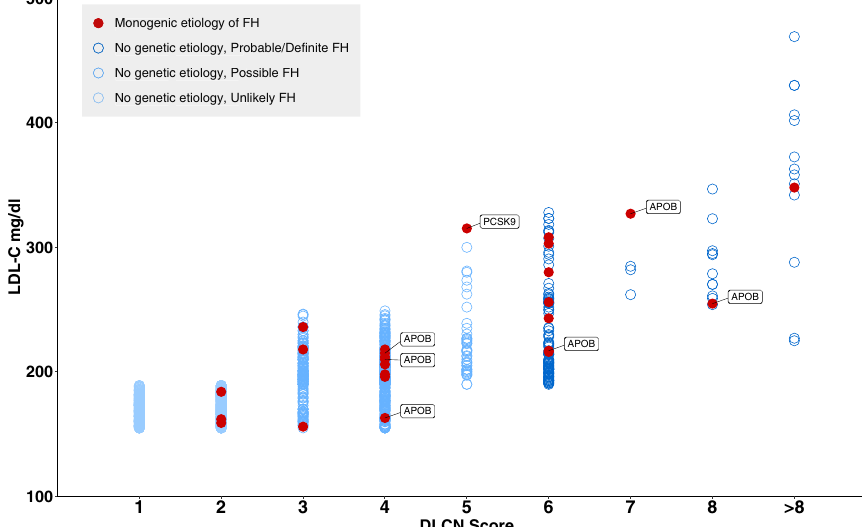
Fig. 4 Distribution of monogenic etiology across categories of DLCN score and corresponding LDL-C levels. Cases with P/LP APOB or PCSK9 variants are labeled and the remaining had P/LP LDLR variants. DLCN Dutch lipid clinic network, FH familial hypercholesterolemia, LDL-C low- density lipoprotein